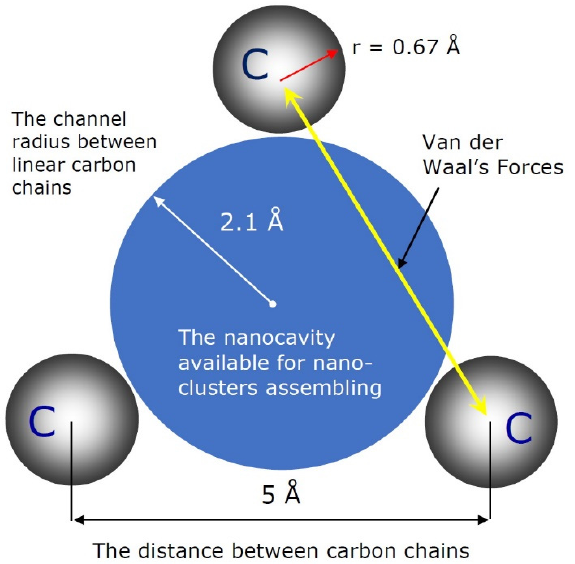
Figure 3. Schematic representation of the vacant nanocavity of the 2D-ordered linear-chain carbon- based nanomatrix available for heteroatom doping.